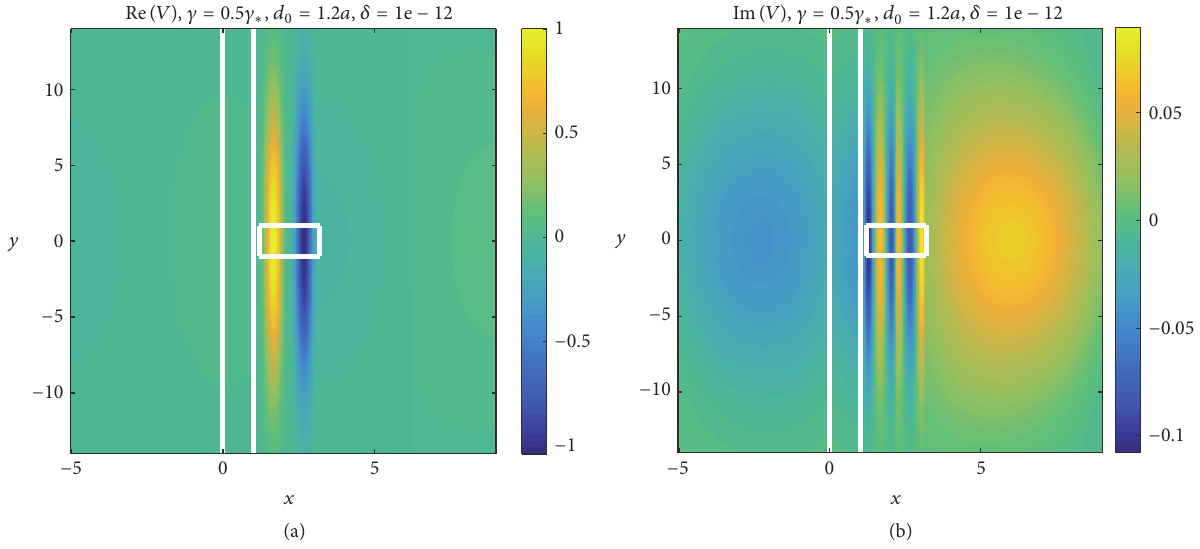
Figure 13: In this figure, we plot (a) Re (𝑉) and (b) Im (𝑉) , where 𝑉 is the solution to (4) corresponding to the source 𝑓 defined through (85)– (87) with the parameters 𝑑 0 = 1.2𝑎 , 𝛾 = 0.5𝛾 ∗ , and 𝛿 = 10 −12 . To make the behavior of 𝑉 clearer, we clipped the maximum and minimum values in each plot to 0.2 (yellow) and −0.2 (blue),